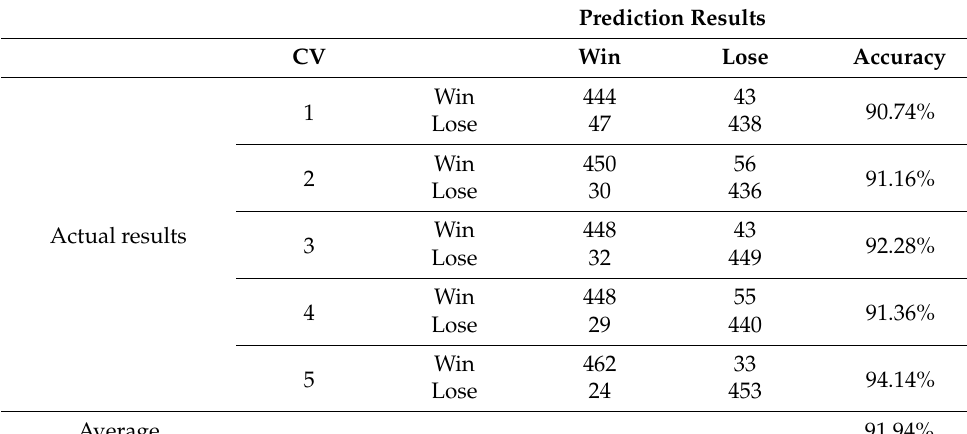
Table 10. Confusion matrix of SVM after feature selection (dataset